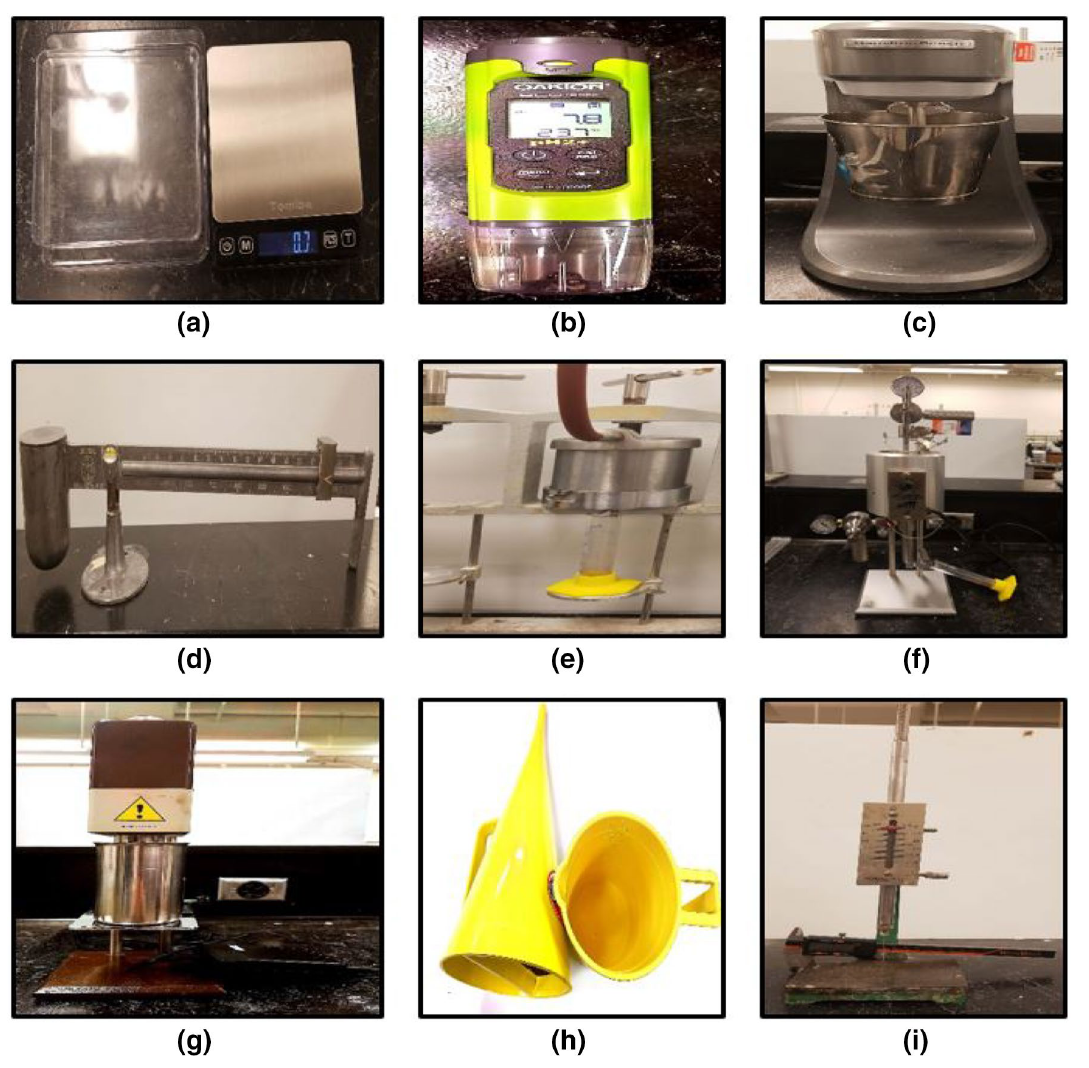
Fig. 4 All mud tests